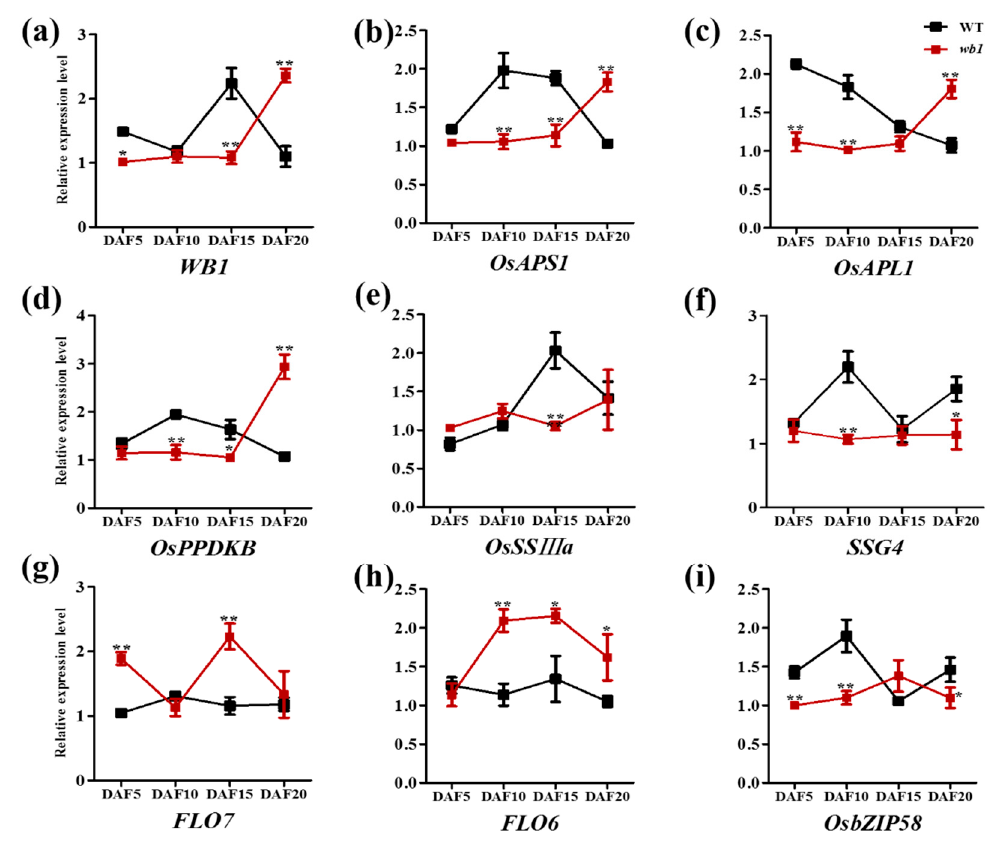
Figure 8. Relative expression analysis of genes associated with starch synthesis by qPCR at four stages of WT and wb1 endosperm development. ( a – i ) Relative expression analysis of WB1 ( a ), OsAPS1 ( b ), OsAPL1 ( c ), OsPPDKB ( d ), OsSSIIIa ( e ), SSG4 ( f ), FLO7 ( g ), FLO6 ( h ), OsbZIP58 ( i ) in WT and the wb1 mutant . All data were compared with the relative expression levels of WT by Student’s t -test (* p ≤ 0.05, ** p ≤ 0.01). Values were means ± SD ( n = 3).